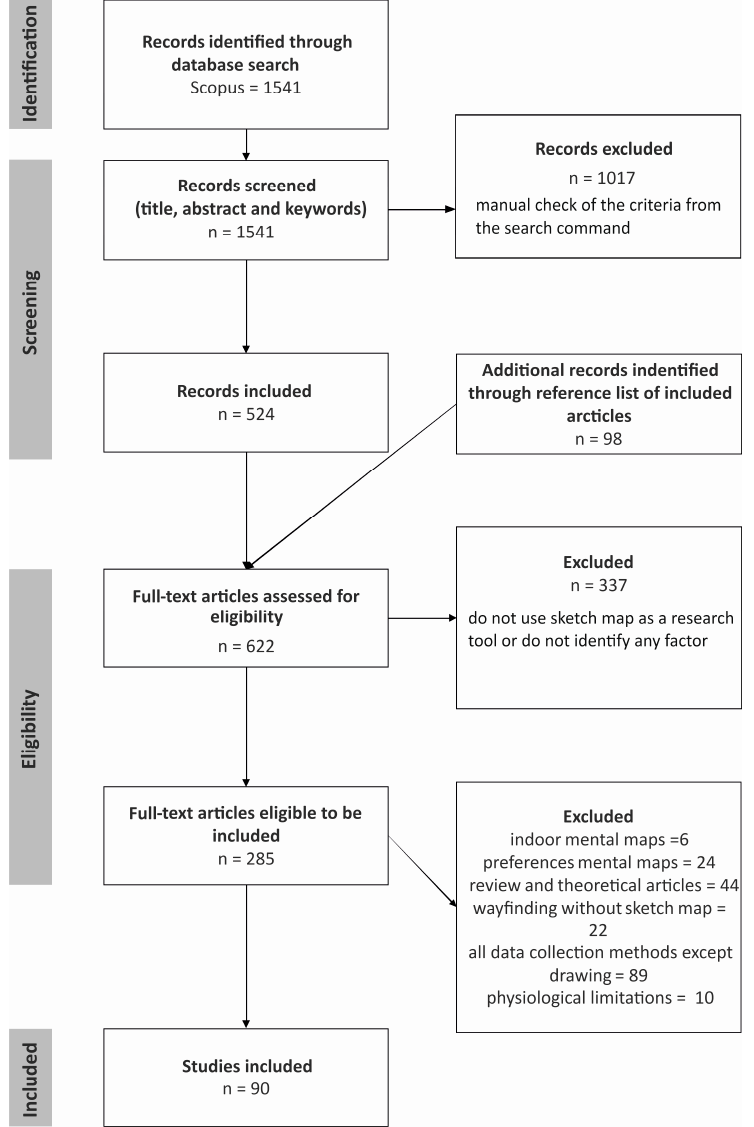
4. Figure 4. Systematic selection of articles for analysis (Source: modified from